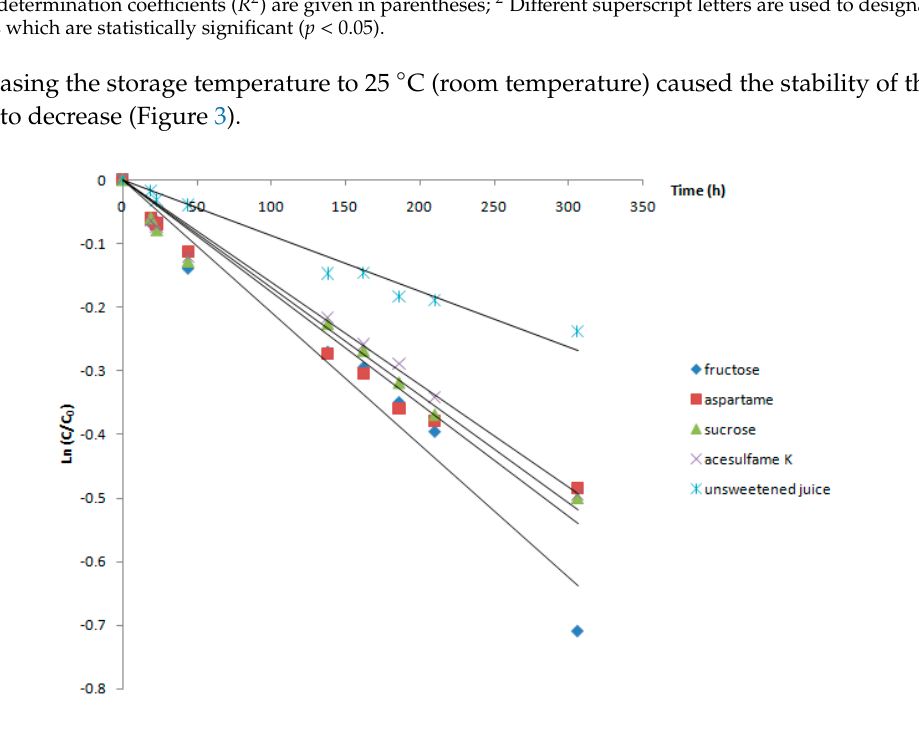
Figure 3. Degradation of the anthocyanins from Cornelian cherry fruit juice at 25 °C.